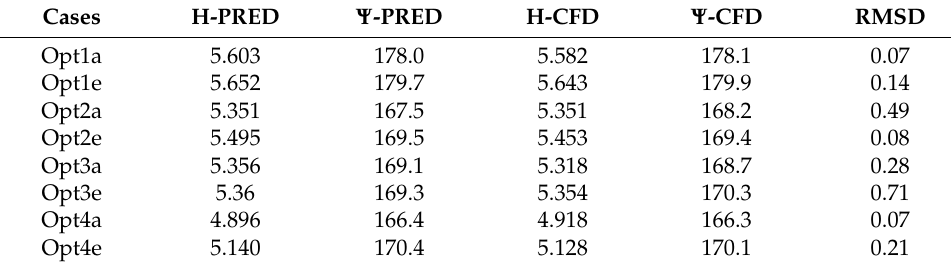
Figure 14. Pareto optimal front for case C3. Table 5. RMSD for the optimal design point in each case.